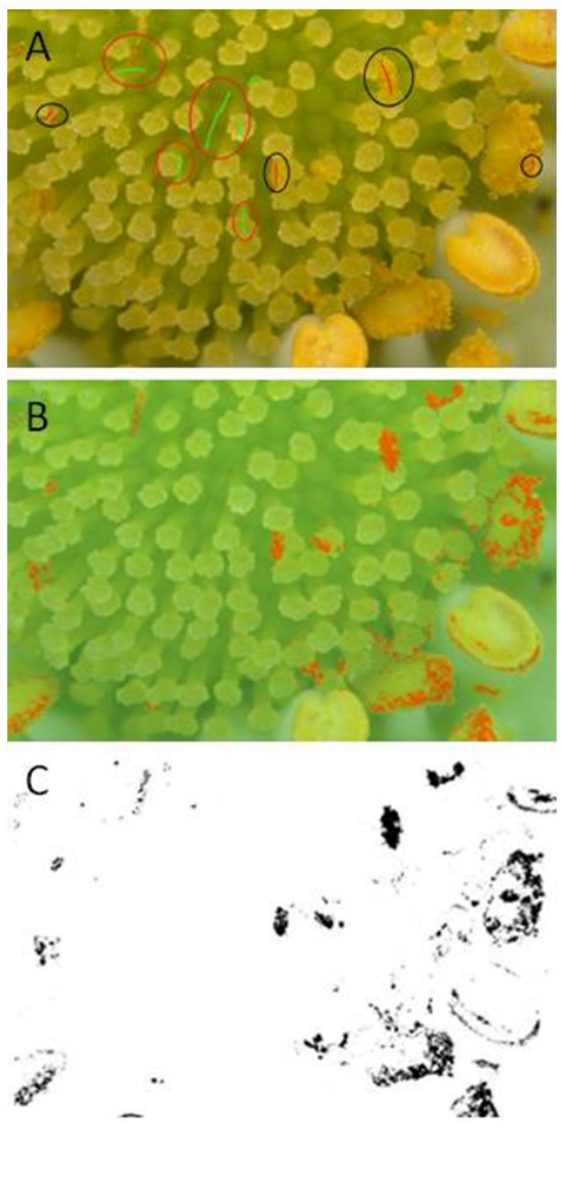
F IGURE 2. Section of macro photograph of strawberry (Fragaria × ananassa) stigmas and several anthers after processing through the Trainable Weka Segmentation (TWS) application in ImageJ. A) The TWS training window; red lines are the classification selections for pollen (circled in black), and green lines are the classification selections for non-pollen (circled in red). B) The output of the TWS. The orange areas indicate sections classified as pollen. C) The binary image used for the total pollen deposition